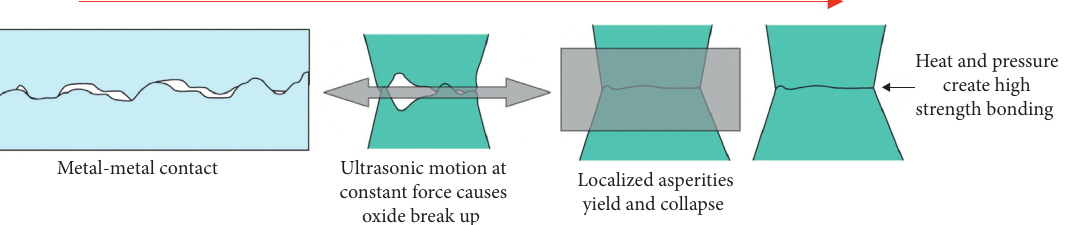
Figure 2: Steps in attaining high-strength bonds via ultrasonic consolidation